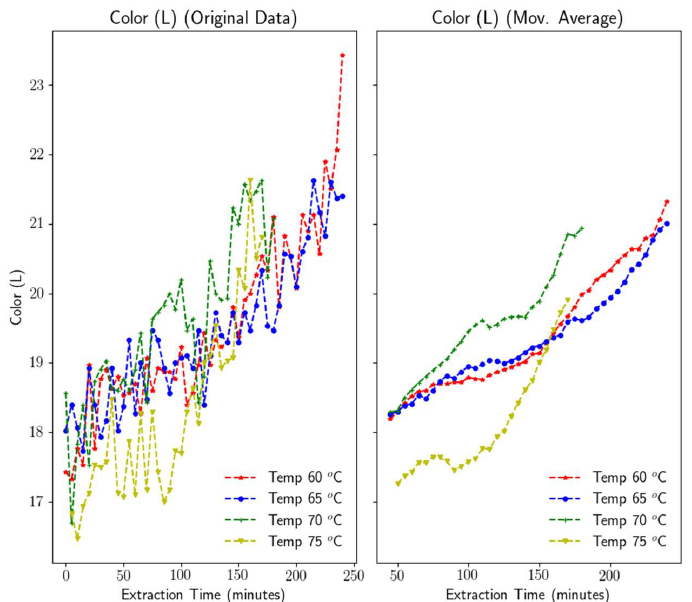
Figure 8. Color (L) with different extraction times and at different temperatures.